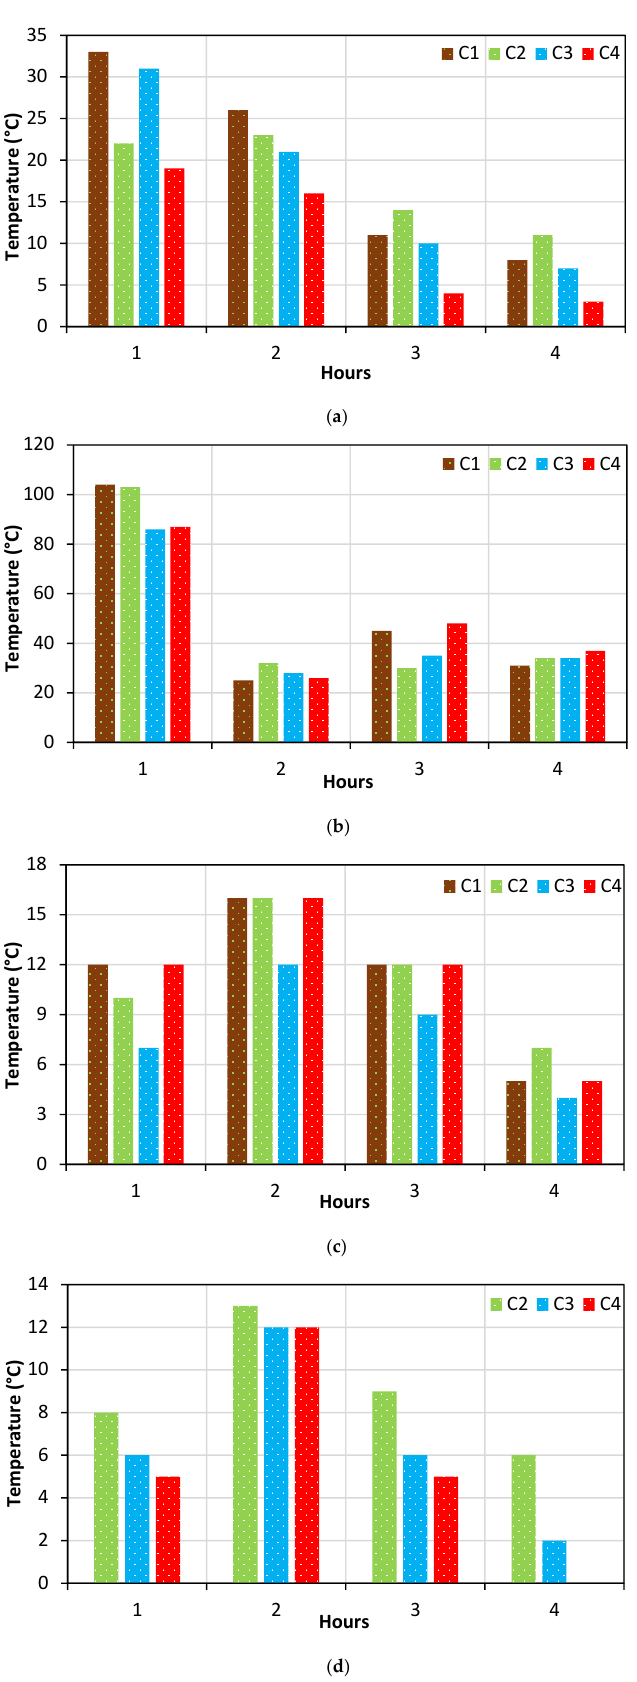
Figure 19. Temperature rise in the specimens every hour at ( a ) top, ( b ) middle, ( c ) and bottom ( d ) cone.